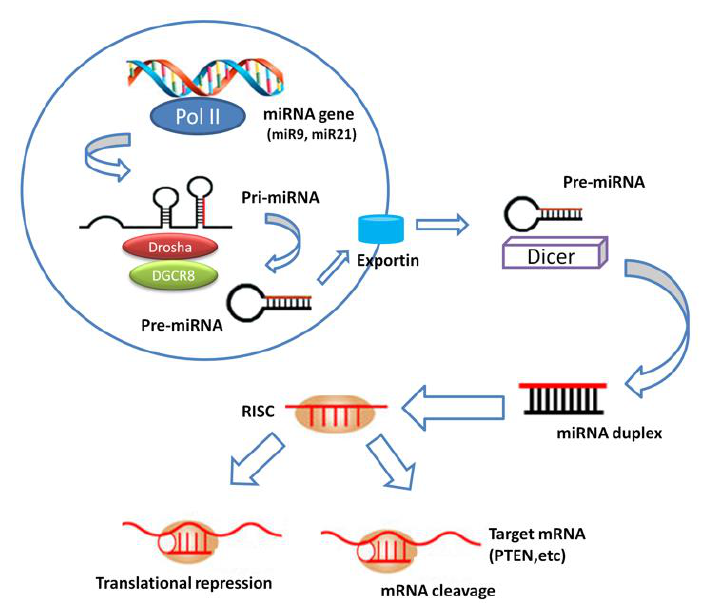
Figure 1. MiRNA biogenesis. miRNA gene is transcribed to generate a primary miRNA (pri-miRNA) precursor molecule that undergoes nuclear cleavage to form a second precursor miRNA (pre-miRNA). The pre-miRNA is exported in the cytoplasm and cleaved to generate a microRNA duplex containing the mature miRNA. The duplex unwinds and the mature miRNA assembles into RISC. The miRNA base-pairs with target mRNA to perform gene silencing trough mRNA cleavage or translation repression.